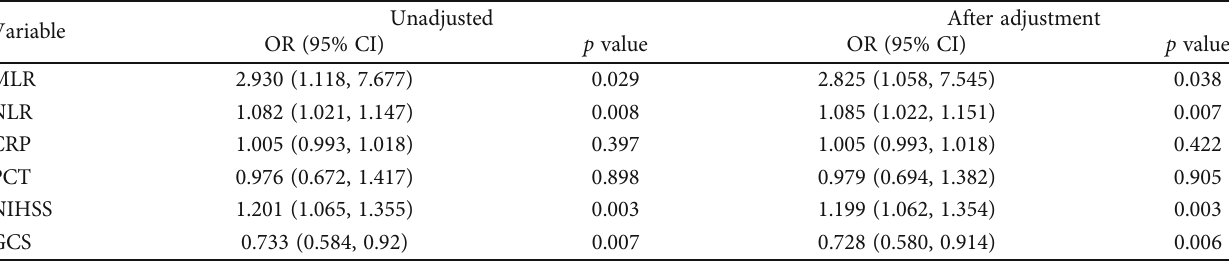
Table 4: The markers that predict in-hospital mortality.